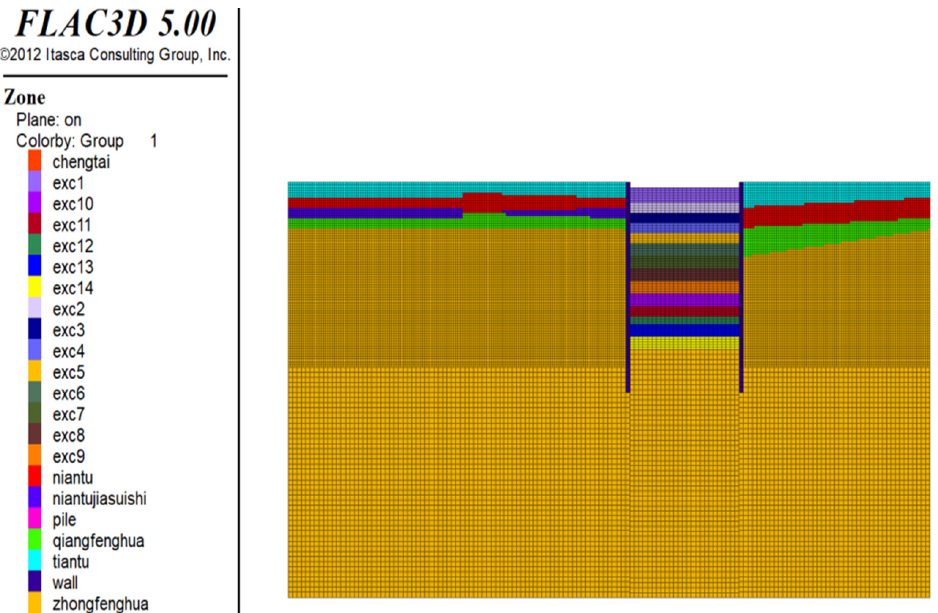
Figure 8. A schematic diagram of excavation processes.